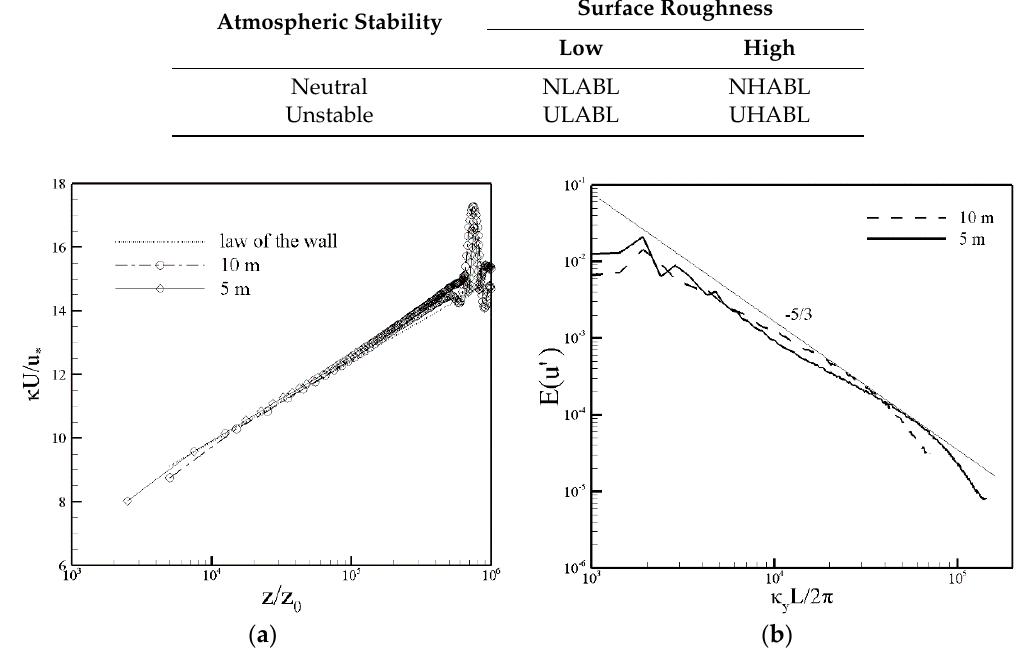
Figure 1. ( a ) Mean streamwise velocity profile and ( b ) energy spectra for the NLABL (refer to Table 1)